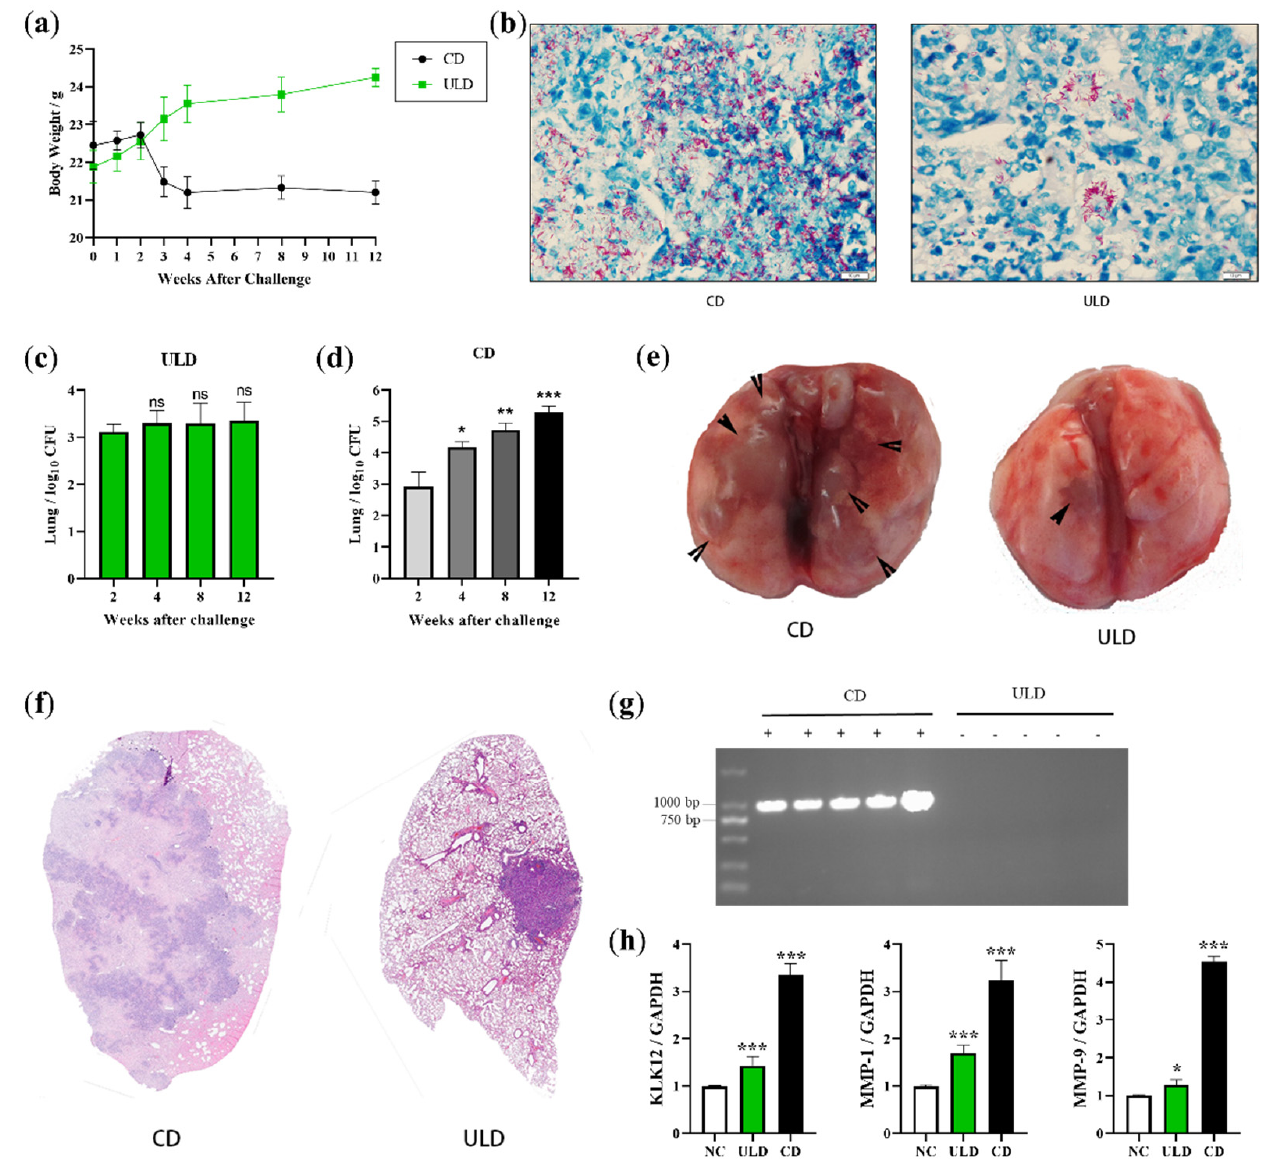
Figure 4. Establishment of LTBI model in B6 mice infected with ULD of M. bovis . B6 mice ( n = 20) were intranasally infected with M. bovis (at doses of 200 CFU/mice or 2 CFU/mice) or with PBS. ( a ) Subsequently, weights were measured at the same time points, and weight change curves were plotted. Three mice were sacrificed after 2, 4, and 8 weeks of infection, organs and sera were collected, ( e ) and gross lung lesions were observed. ( c , d ) Then, the inferior lobe of the right lung and the whole spleen were ground and coated on 7H10 agar plates for bacterial load statistics. The left lung was fixed with formaldehyde, and tissue sections were stained with ( f ) H&E and ( b ) acid-fast stains. ( g ) DNA of mice pharyngeal swabs was extracted for PCR detection of M. bovis . ( h ) RNA of lung tissues was extracted and reverse transcribed into cDNA for qPCR detection of KLK12, MMP-1, and MMP-9 transcription levels. Analysis of data using GraphPad Prism software (* p < 0.05; ** p < 0.01; *** p <